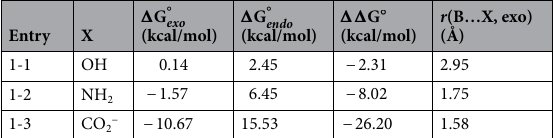
Table 2. Results of the DFT calculations on the final products of the three DA reactions outlined in Fig. 1.